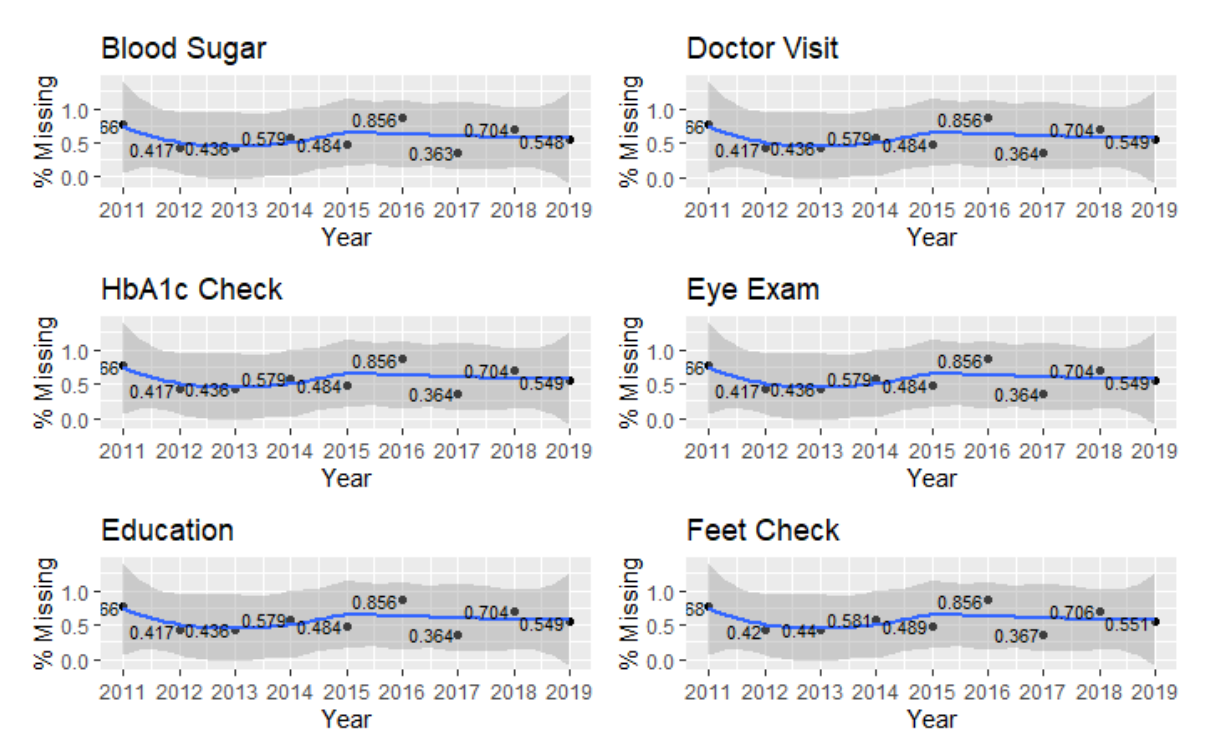
Figure 1. Missing value proportions for each dependent variable by year.